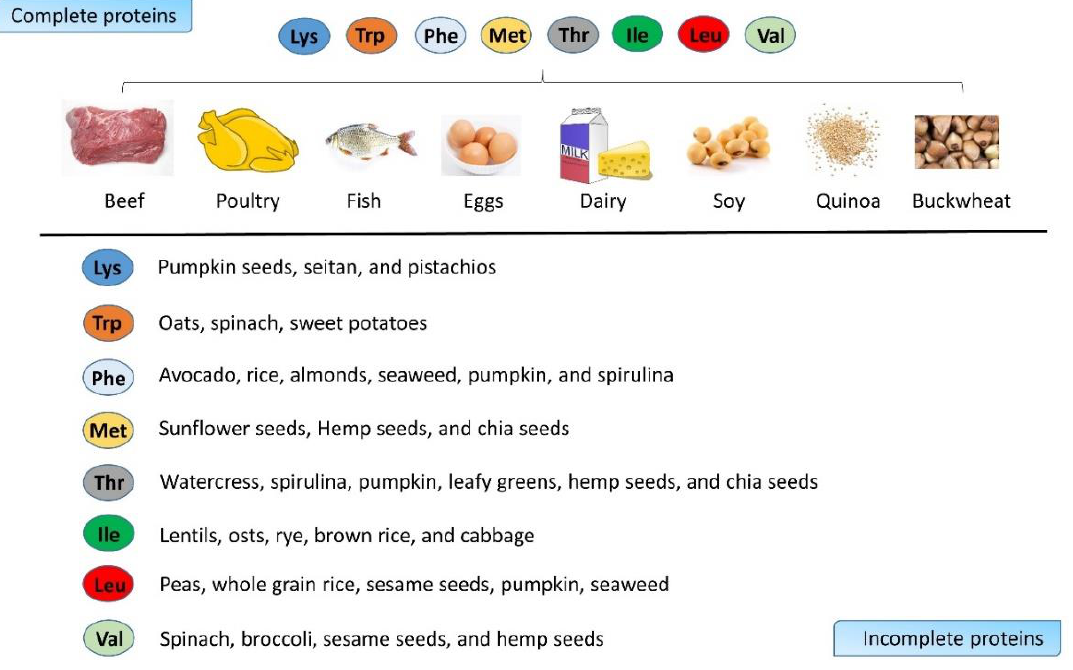
Figure 1. Sources of EAAs from complete proteins and incomplete proteins.